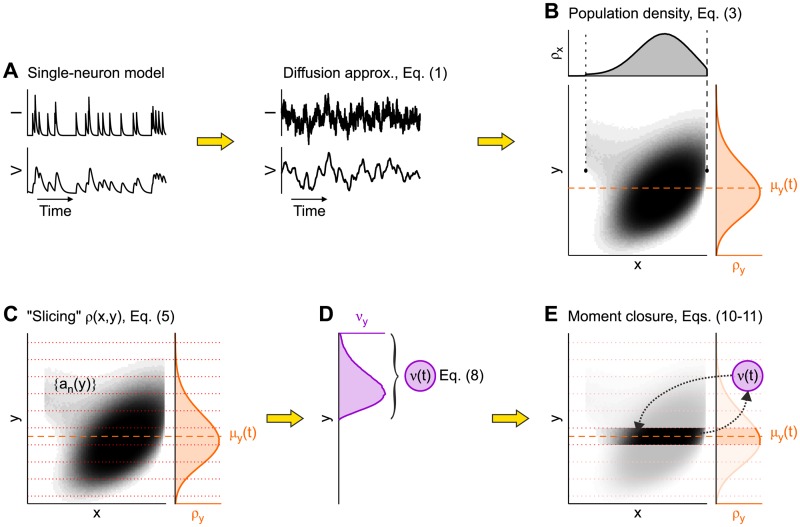
Sketch of the main steps of the theoretical derivation.(A) Diffusion approximation (right) of the single-neuron dynamics. (B) Probability density ρ(x, y) at fixed t, with the associated marginal distributions for both membrane potential (ρx, gray) and current (ρy, orange). Orange dashed line: instantaneous mean μy of the current (see main text for details). (C) “Slices” of the two-dimensional ρ(x, y) bounded by red dotted lines; each “slice” (which actually has infinitesimal thickness) corresponds to a one-dimensional subpopulation of neurons with similar y and is described by the expansion coefficients {an(y)} of a suited one-dimensional FP operator. (D) Partial firing rates νy (purple) are integrated over y to obtain the ν(t) of the whole network. (E) The instantaneous firing rate ν(t) is now the only state variable needed to be fed back in order to operate the moment closure and take into account only the “slice” centered around μy (the 0-th order approximation).